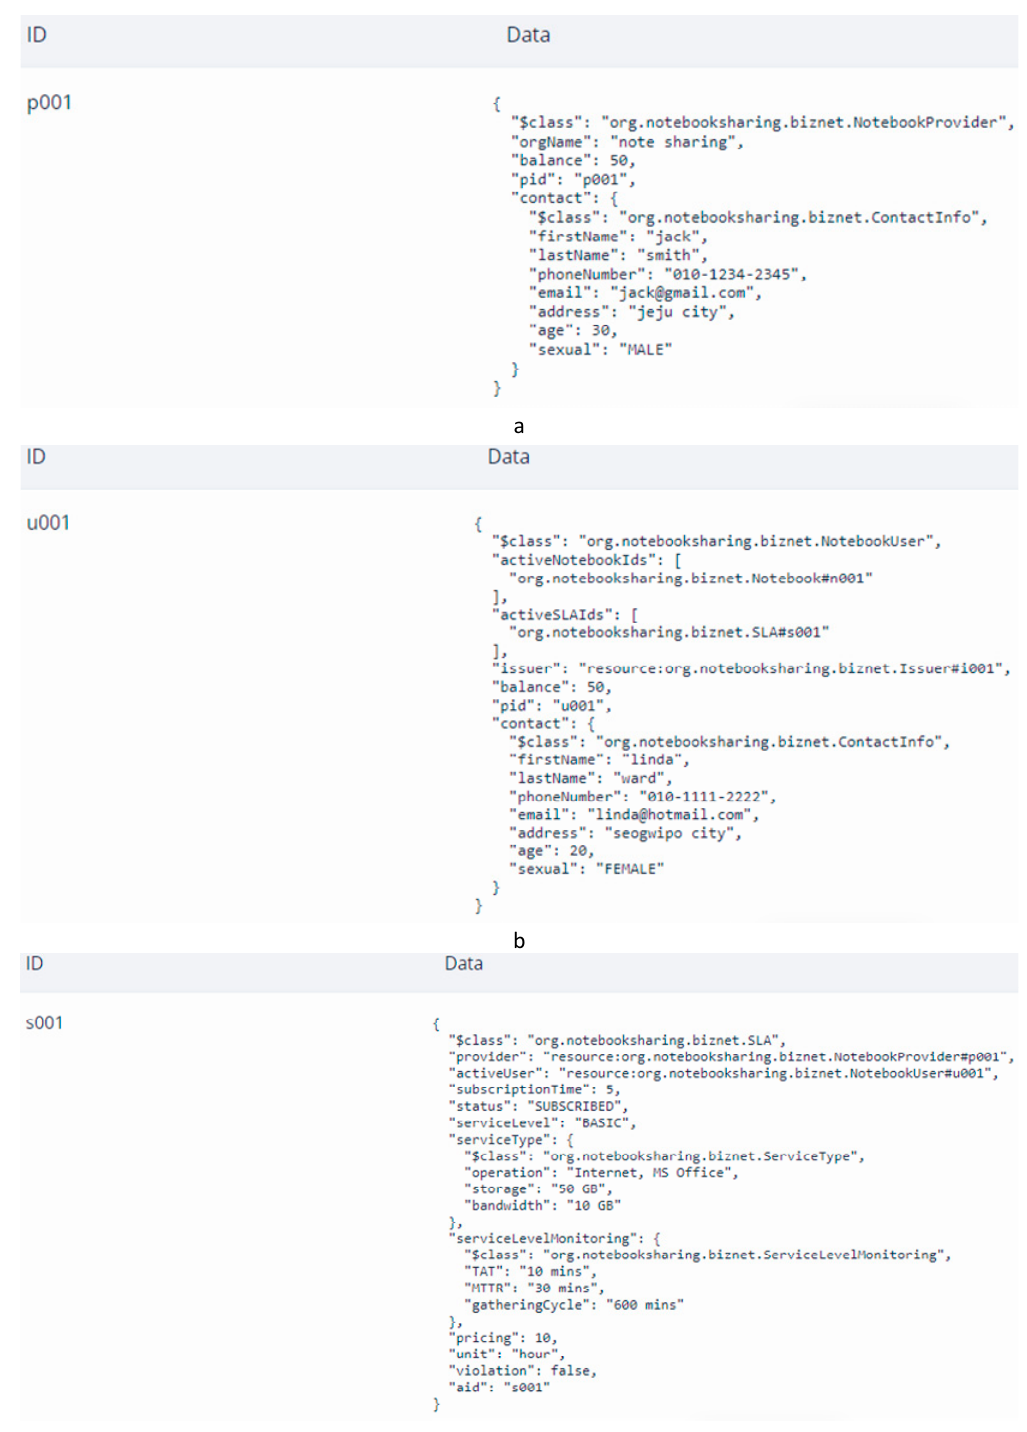
Figure 18. Snapshot of the case study operation results. ( a ) Provider profile; ( b ) consumer profile; ( c ) SLA specification.